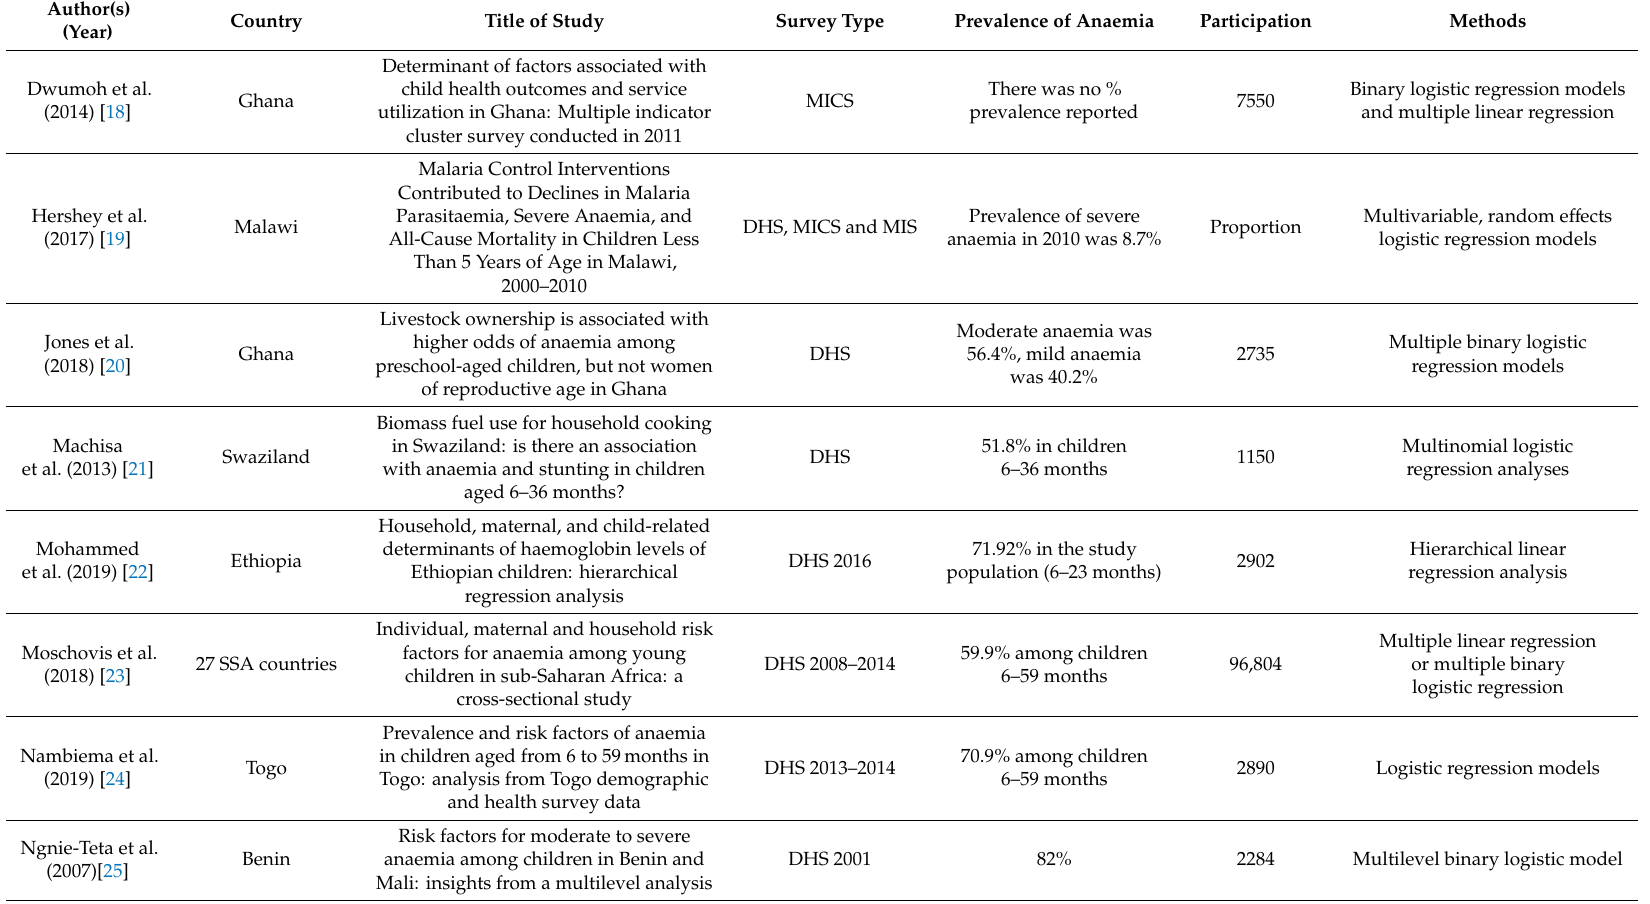
Table 1. Characteristics of the selected studies on anaemia ( n =